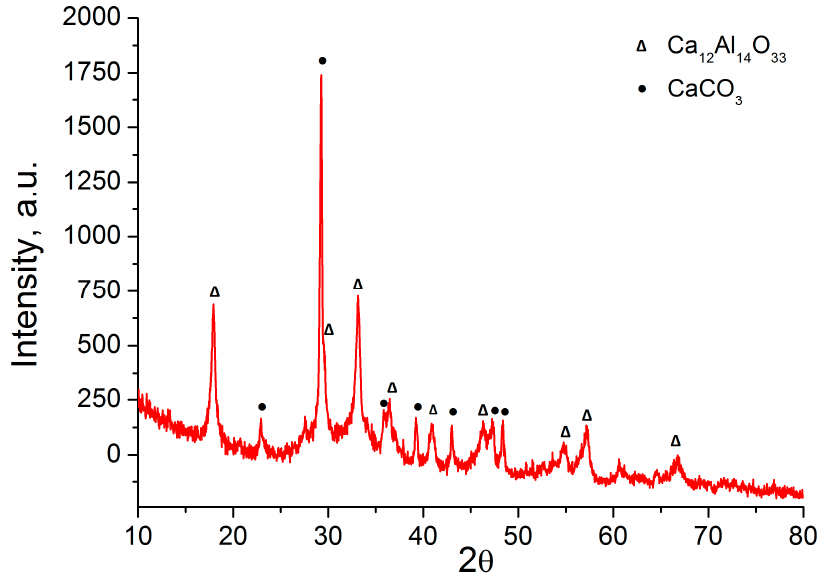
Figure 1. XRD pattern of mayenite 10. 75